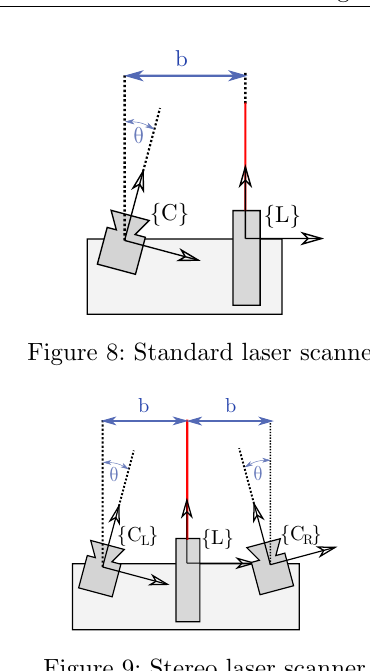
Figure 9: Stereo laser